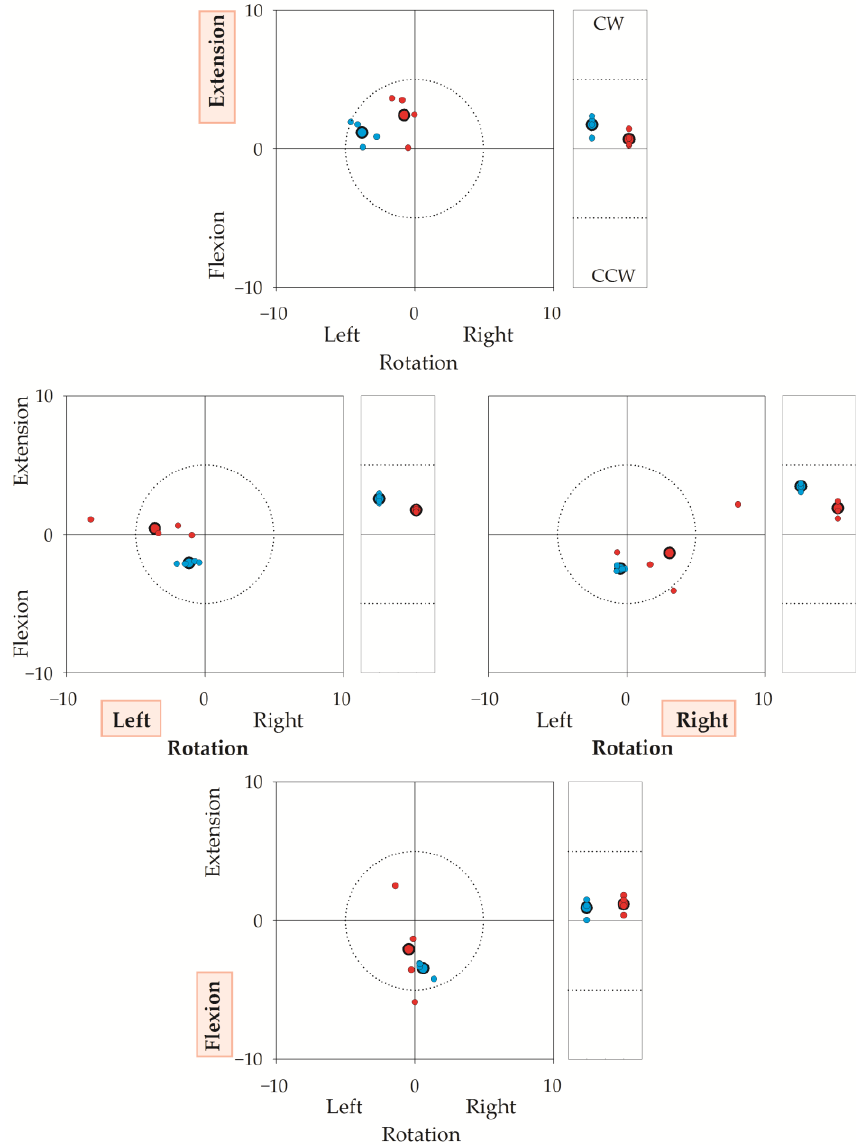
Figure 5. The figure illustrates the target reference points (0,0 coordinates), the Target Positions (TPs) and Reached Positions (RPs) in a representative sequence of 32 repetitions (16 trials) performed by a participant–operator couple. Axes give angular errors in degrees. TP is the head’s final position when the participant’s head was moved by the operator; RP is the position reached autonomously by the participant. Each small dot corresponds to the TP (blue) or the RP (red) of a single repetition. Big dots with a bold border represent the average of the four repetitions. In a trial, the operator first rotated the participant’s head from the neutral head position to the target reference point (30 ◦ for left or right rotation, 25 ◦ for flexion or extension). If the operator was errorless, TP coincided with the target reference point (0,0 coordinates). Then, after the operator-assisted repetition, the participant autonomously turned their head from the neutral head position to TP. If the participant was errorless, RP coincided with TP. Thus, if both the operator and the participant were errorless, RP and TP coincided with the target reference point. To stress, the operator had to be accurate and precise with respect to the target reference point, while the participant had to be accurate and precise with respect to TP. For each trial, OPE was calculated as the difference in degrees between the coordinates of the TP and 0,0. Participants completed (in quasi-random sequence) neck extensions (upper graph), left-right rotations (middle graphs),